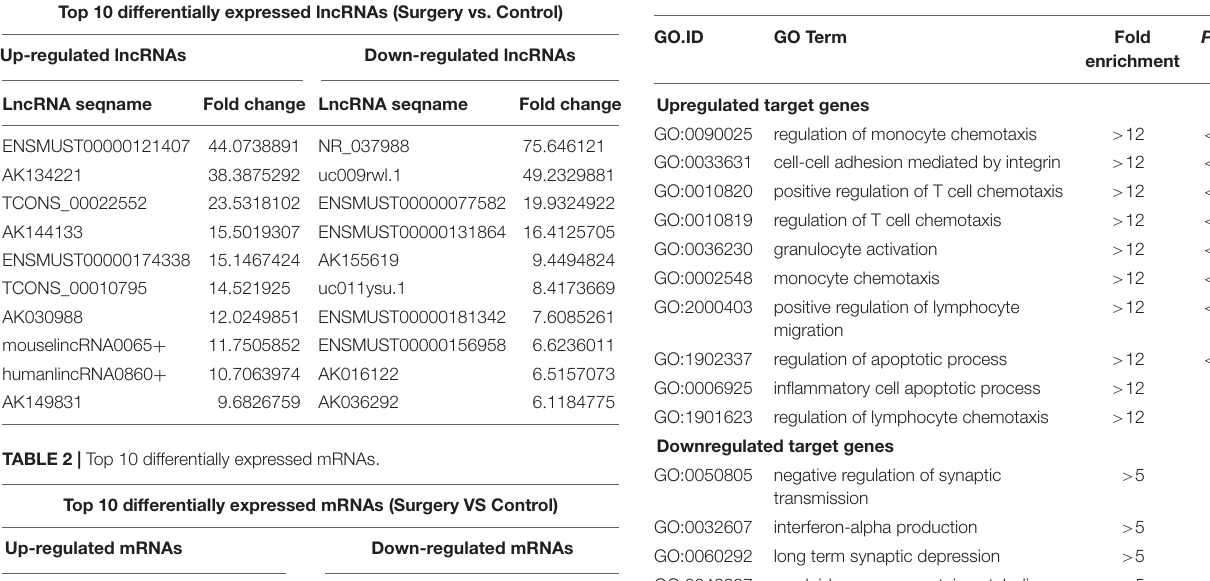
TABLE 3 | Top 10 GO biological processes of upregulated target genes and top 6 biological processes of downregulated target genes (surgery vs. control).